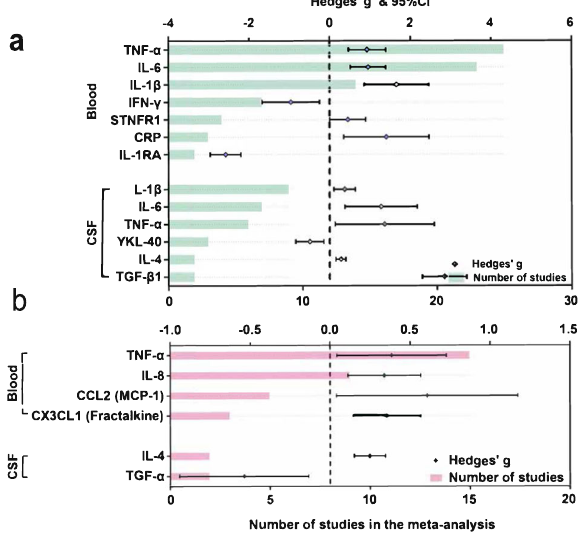
Fig. 4 Subgroup comparative outcomes of fl uid biomarkers strati fi ed by different assay types in the meta-analysis. Signi fi cant comparisons of peripheral blood and CSF biomarkers using ELISA ( a ) and multiplex cytokine ( b ) are shown. In fl ammatory markers with signi fi cant effect sizes (Hedges ’ g) were displayed in comparisons of PD patients versus controls. Violet ( a ) and dark green ( b ) spots indicate Hedges ’ g of each marker, and green ( a ) and pink ( b ) bars indicate the number of studies included. Abbreviations : CRP C-reactive protein, CSF cerebrospinal fl uid, CX3CL CX3 chemokine ligand, ELISA enzyme-linked immunosorbent assay; IFN interferon, IL interleukin, IL-1RA IL-1 receptor antagonist, MCP monocyte che- moattractant protein, TGF transforming growth factor, TNF tumour necrosis factor, YKL chitinase-3-like